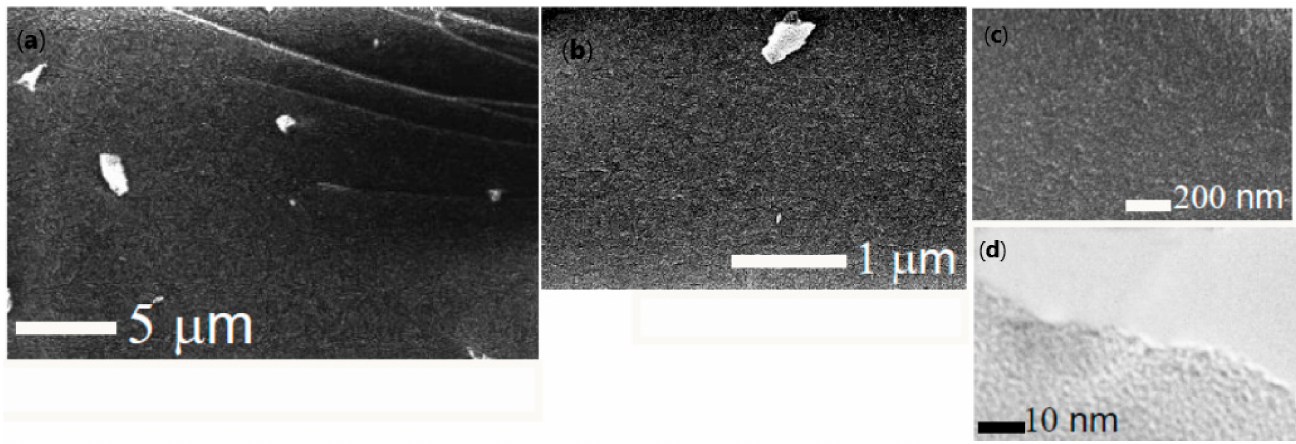
Figure 3. SEM ( a – c ) and TEM ( d ) images of the same sample of SiO 2 . They were taken at different magnifications. TA was preliminarily removed by washing in water. The sol-gel synthesis was performed by admixing 20 wt% THEOS to a 2 wt% TA